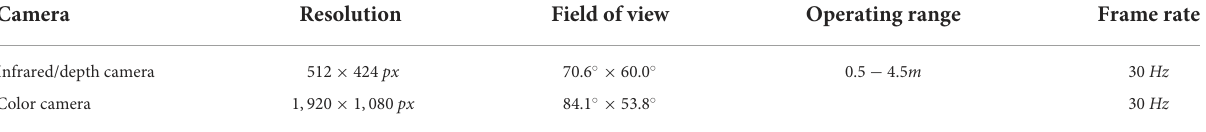
TABLE 1 Kinect v2 specifications.